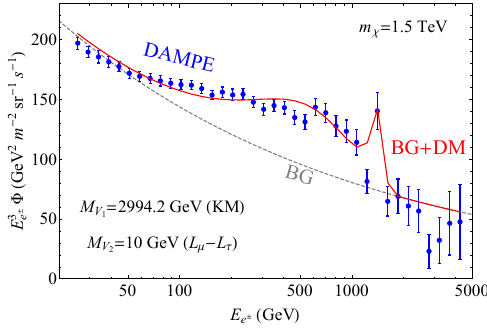
Figure 4 . DAMPE electron energy spectrum. Overlaid is the sum of cosmic ray background and the electron (cid:13)ux from DM annihilations from the MW halo and from the nearby subhalo. Here V 1 kinetically mixes with the SM hypercharge boson and V 2 is the gauge L (cid:22) (cid:0) L (cid:28) boson. The DM annihilation cross sections h (cid:27)v i 1 = 3 : 9 (cid:2) 10 (cid:0) 25 cm 3 /s (for all SM (cid:12)nal states in the (cid:31) (cid:22) (cid:31) ! V 1 ! f (cid:22) f process) and h (cid:27)v i 2 = 2 : 0 (cid:2) 10 (cid:0) 24 cm 3 /s (for the (cid:31) (cid:22) (cid:31) ! V 2 V 2 process) are used